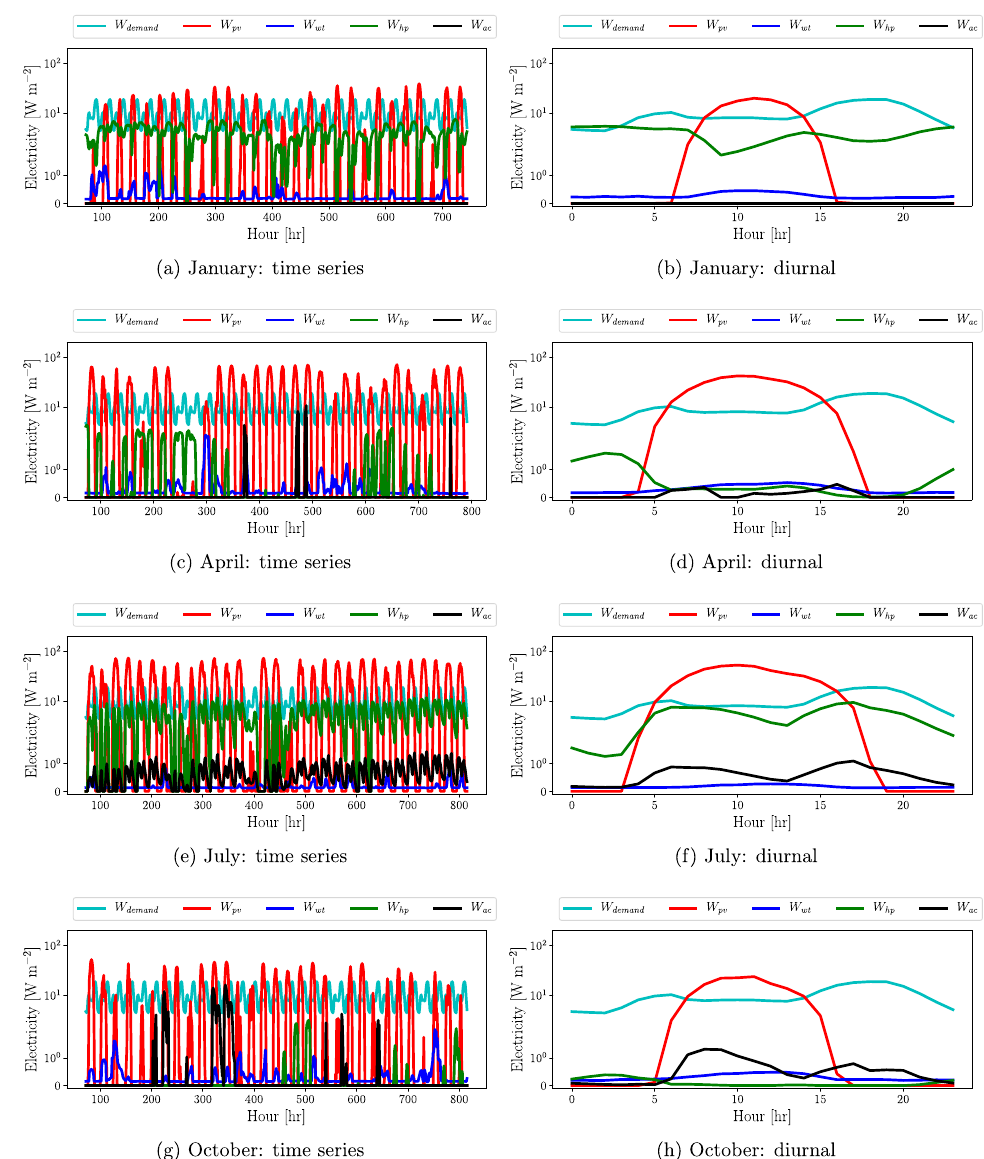
Figure A3. System electricity flows: time series ( a , c , e , g ) and diurnal ( b , d , f , h ) variation of electricity demand W demand , photovoltaic electricity generation W pv , wind turbine electricity generation W wt , and heat pump electricity consumption W hp , air conditioning electricity consumption W ac , all in [W m − 2 ]; all terms reported per unit building footprint area; and diurnal variation is shown for the mean values at every diurnal